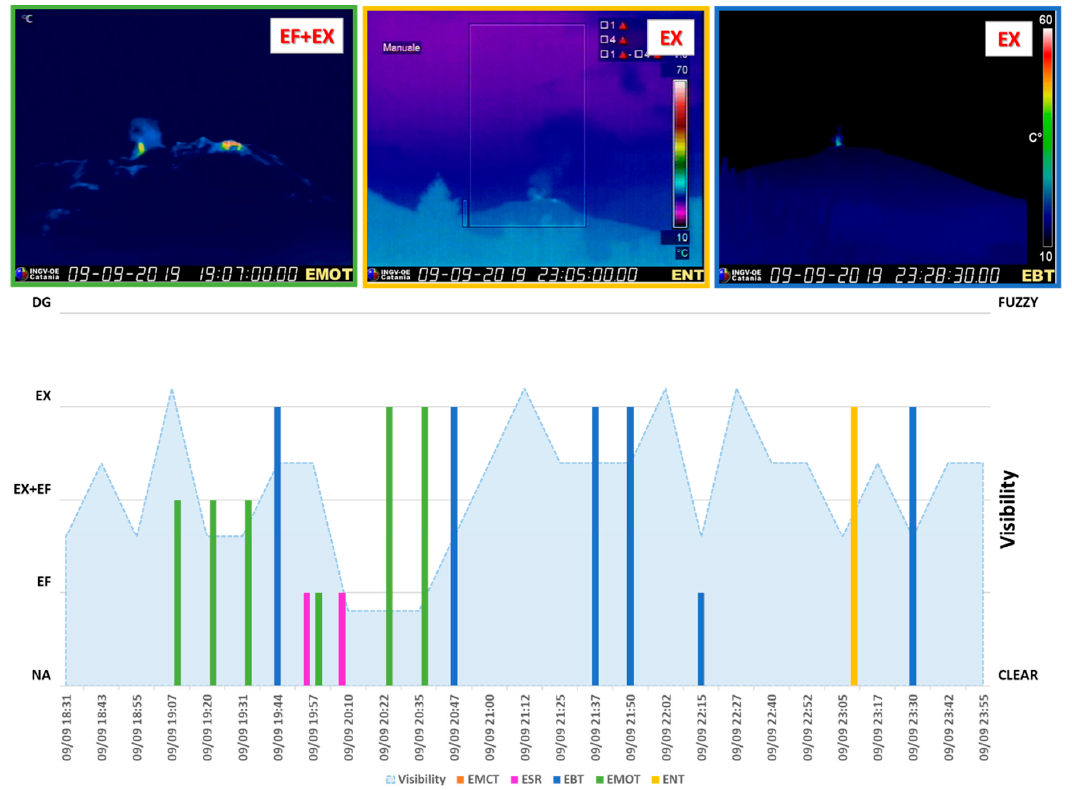
Figure 7. Volcanic activity evolution detected by the ML algorithm from the 18:26 to 23:38 UTC of 9 September, 2019. “DG”, “EX”, “EX+EF”, “EF” and “NA” stand for degassing, explosive, explosive and e ff usive, e ff usive and no activity respectively. The visibility index is given by the average of the visibility indexes for all the